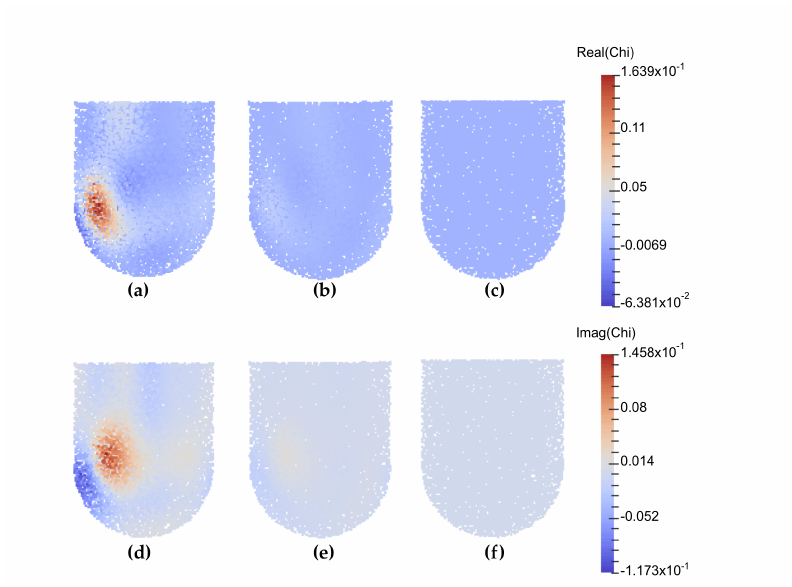
Figure 8. Point cloud representation of the CSI reconstruction of the real and imaginary parts of the complex contrast for the fibroglandular region for the T1 test examples with ( a , d ) a 9 mm tumor at position T1, ( b , e ) a 4.5 mm tumor at position T1, and ( c , f ) no